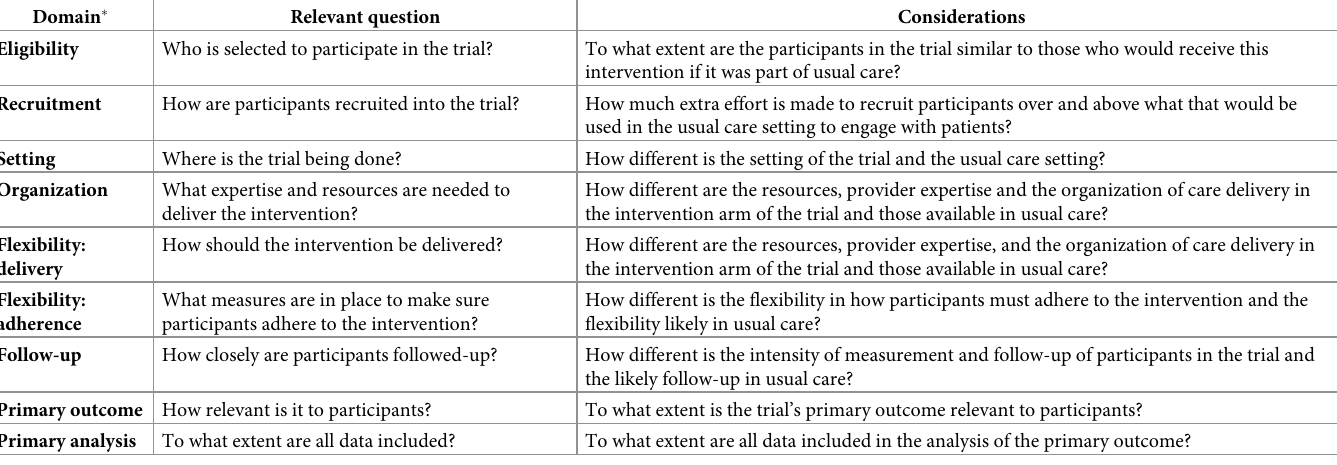
Table 2. PRECIS-2 tool to assess real-world relevance and feasibility of research